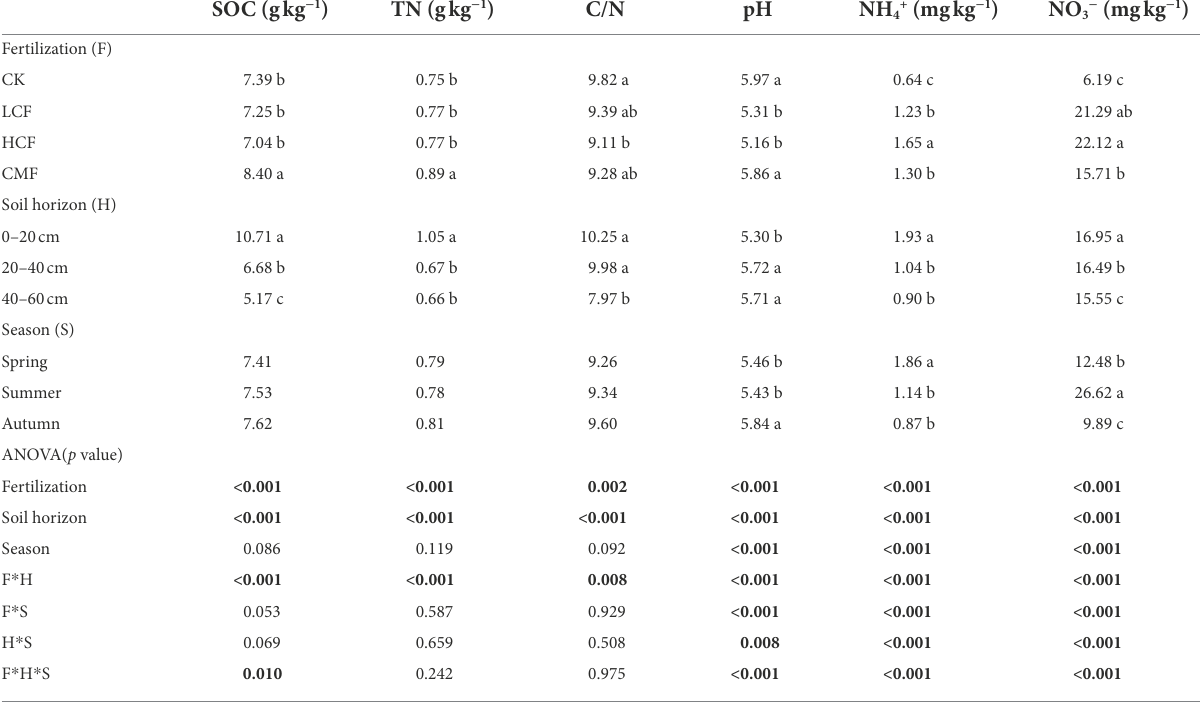
TABLE 1 Effects of fertilization, soil horizon, and season on soil chemical